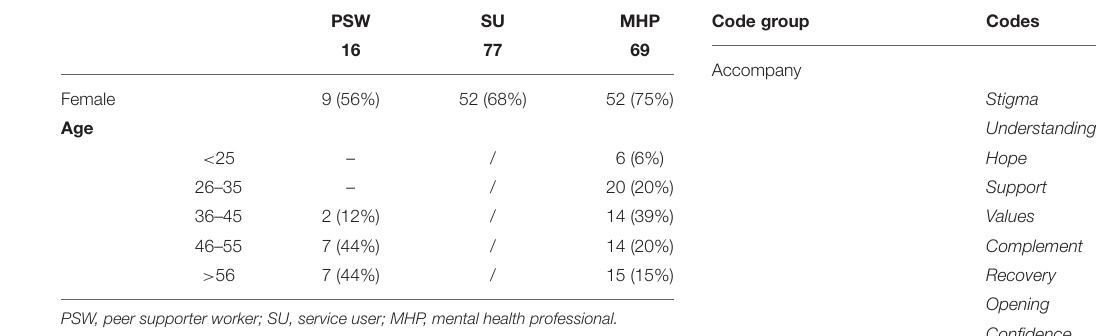
TABLE 3 | Baseline demographics. TABLE 4 | Qualitative analysis: codes, group of codes, and